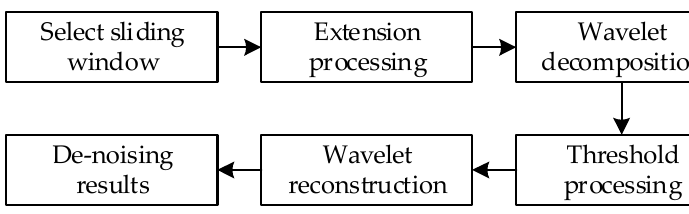
Figure 2. Flowchart of real-time wavelet threshold de-noising.